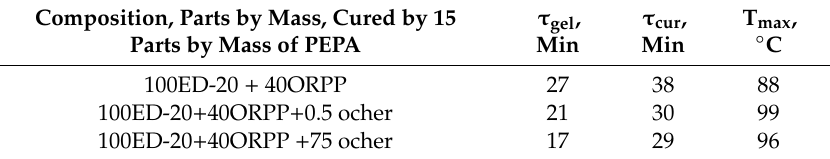
Figure 8. Kinetic curves of the curing process of compositions, parts by mass: 1 — 100ED-20 + 40ORPP + 15PEPA; 2 — 100ED-20 + 40ORPP + 0.5Ocher + 15PEPA; 3 — 100ED-20 + 40ORPP + 75Ocher + 15PEPA.